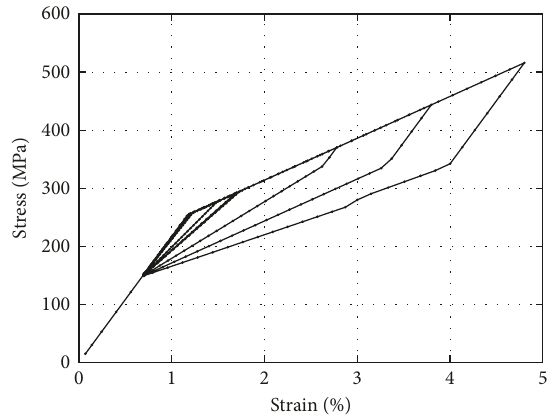
Figure 20: Stress-strain response of a typical SMA